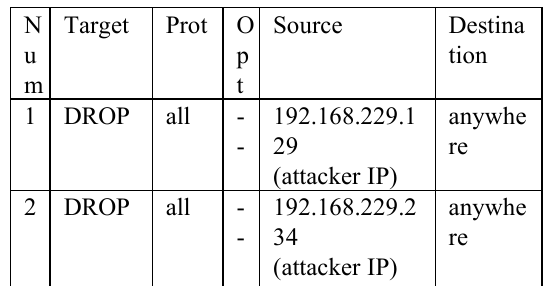
Table.2 IPtables rules after prevention of the TCP SYN Flood